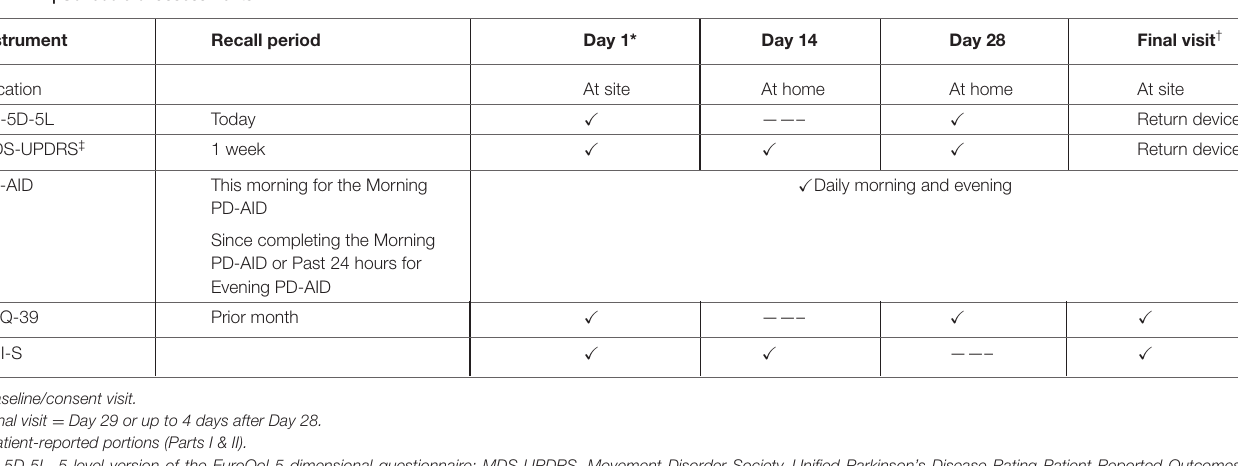
TABLE 1 | Schedule of assessments.